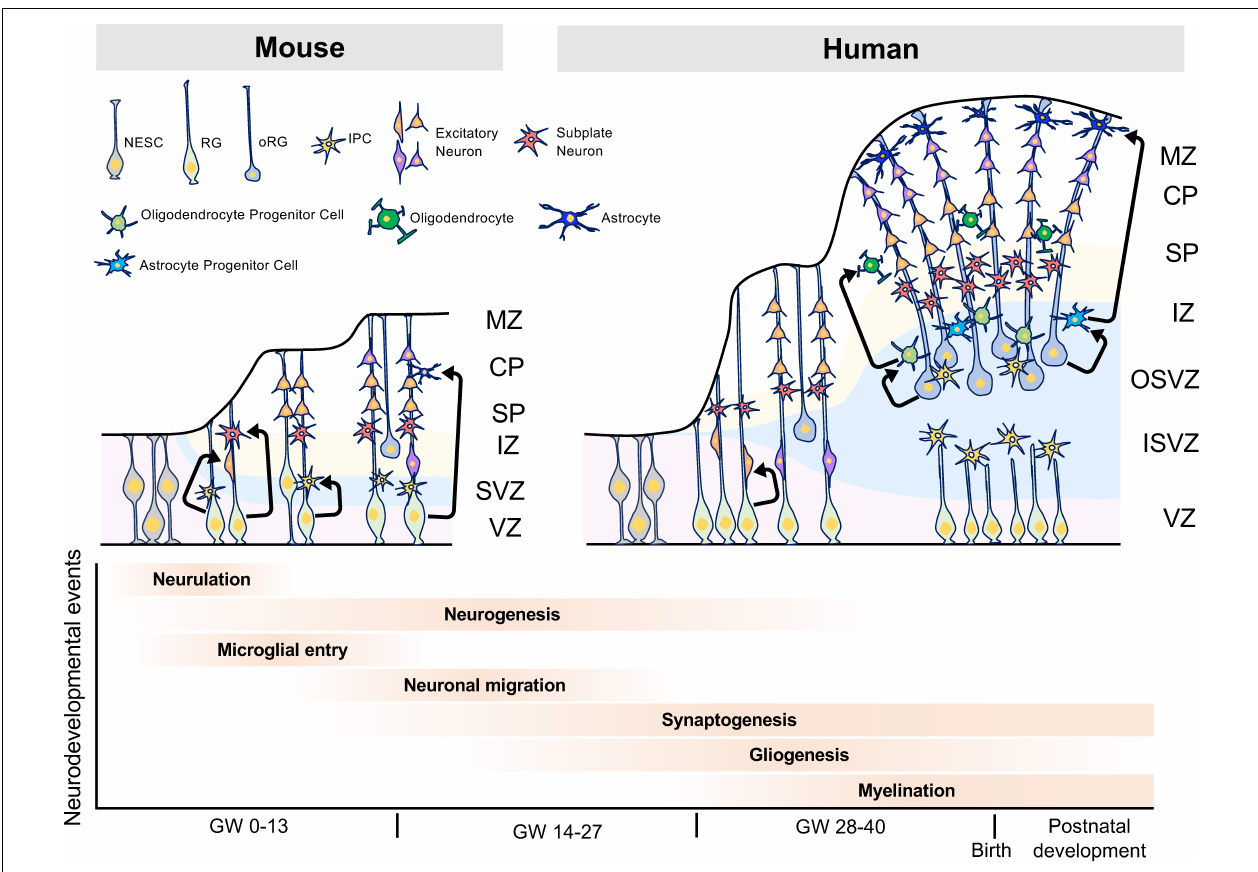
FIGURE 1 | Characteristics of human brain development. The human brain has the OSVZ and ISVZ as anatomical features, while the mouse brain has only the SVZ as a thin layer. The OSVZ contains a large number of oRGs that have replication and differentiation potential, and this layer is important for the evolution and expansion of the human brain. Furthermore, the expansion of white matter by oligodendrocytes is thought to have contributed to the evolution of the human brain and the acquisition of higher brain functions. NESC, neuroepithelial stem cell; RG, radial glia cell; oRG, outer radial glia cell; IPC, intermediate progenitor cell, MZ, marginal zone; CP, cortical plate; SP, subplate; IZ, intermediate zone; SVZ, subventricular zone; VZ, ventricular zone; OSVZ, outer subventricular zone; ISVZ, inner subventricular zone; GW, gestational